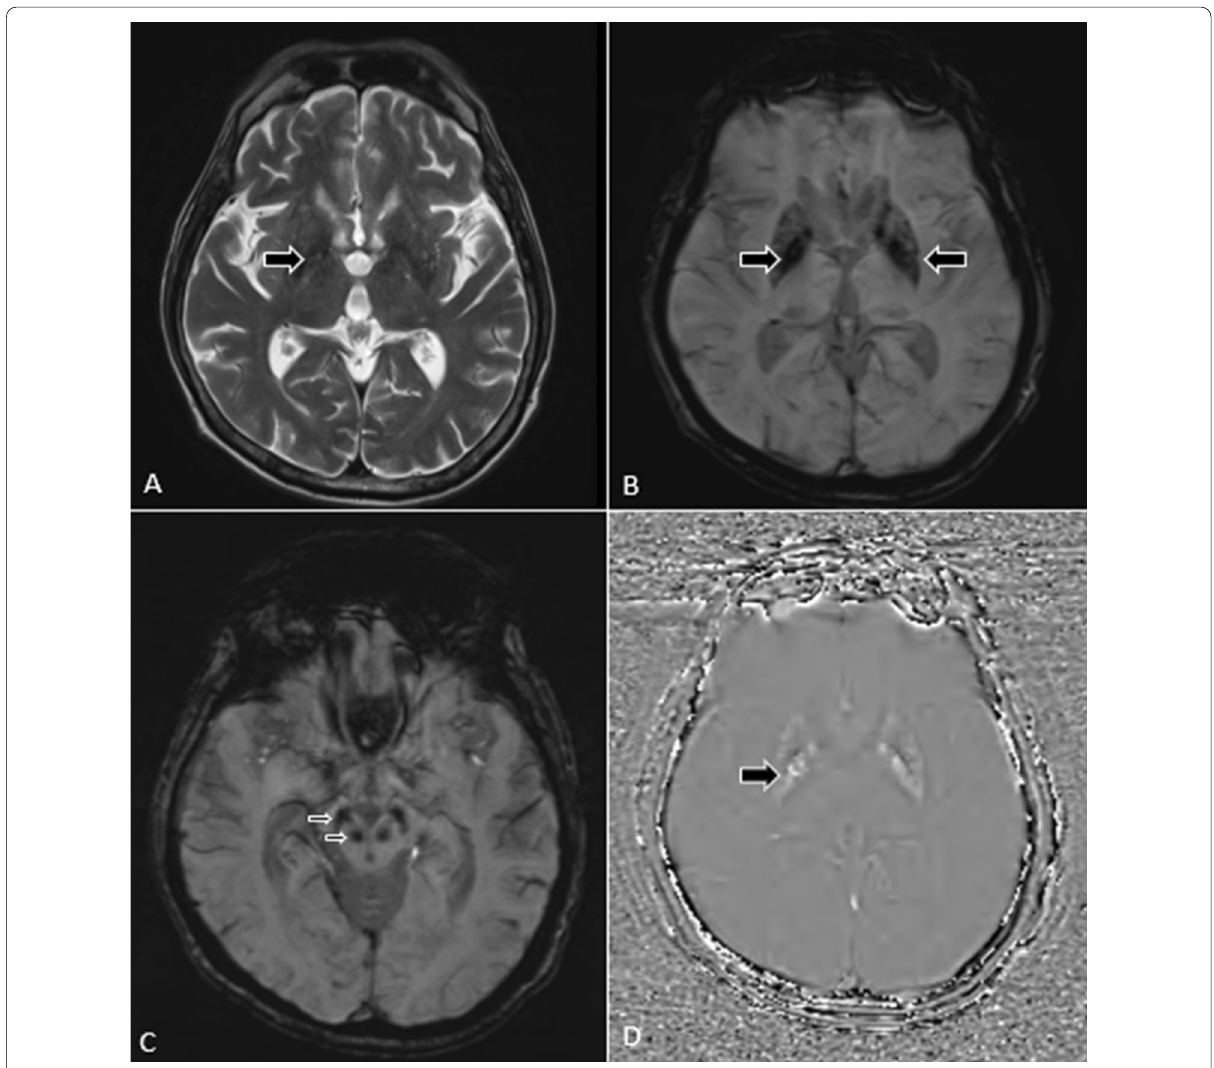
Fig. 2 Magnetic resonance imaging of brain reveals hypointense signals in basal ganglia on T2-weighted image ( A ). Susceptibility-weighted imaging reveals areas of signal dropouts in bilateral basal ganglia ( B ), substantia nigra and red nuclei ( C ) with bright signals in basal ganglia in filtered phase image ( D ). These findings are consistent with mineral